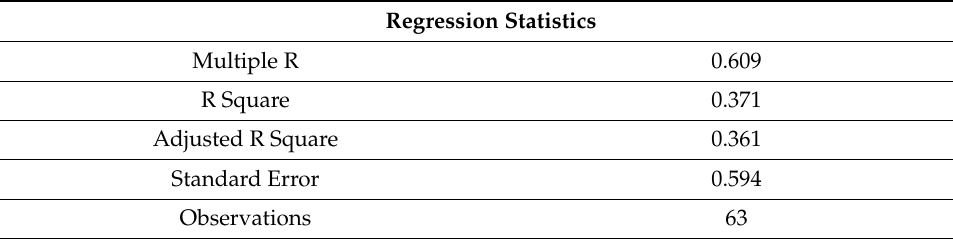
Table 8. Regression analysis statistics.